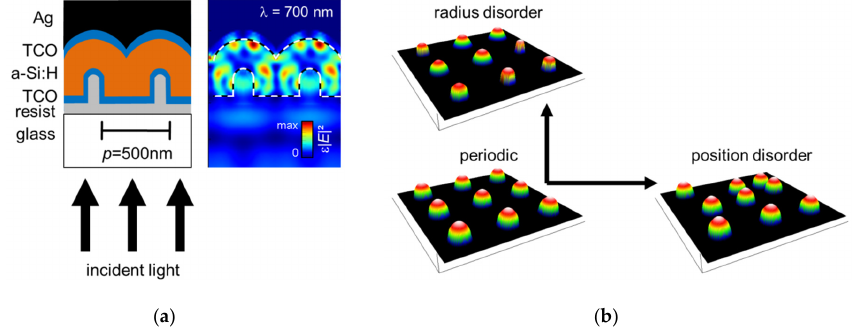
Figure 1. ( a ) Schematic illustration of the nanophotonic thin-film solar cell. The frontside is textured with a periodic array of nanopillars (gray) in the glass superstrate (white) capped by half-spheres and a transparent conductive oxide layer (TCO) as the front contact (blue). The a-Si:H layer (orange) forms the solar cell absorber which is finalized with a back reflector consisting of a TCO (blue) and a perfect electric conductor (black). A cross-section image of the simulated electric field energy for a wavelength of 700 nm is shown on the right side. ( b ) Illustration of different ways of disorder which are introduced to the grating